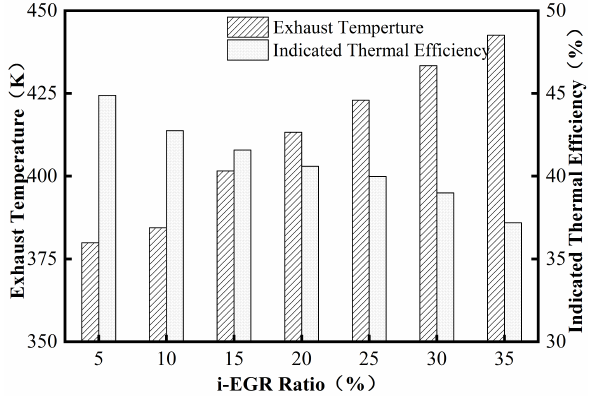
Fig. 15 Effect of i-EGR and e-EGR ratios on exhaust temperature and indicated thermal